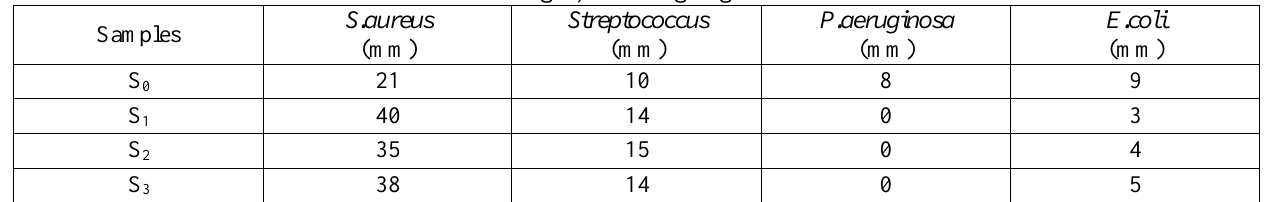
Table 1 : the results of the inhibition zones diameters measured for four types of common bacteria with diverse MgO amounts into the prepared hybrids; where S 0 : the control sample (zero MgO), S 1 : 0.04g MgO, S 2 : 0.06g MgO, S 3 : 0.08g MgO. S.aureus Streptococcus Samples (mm)